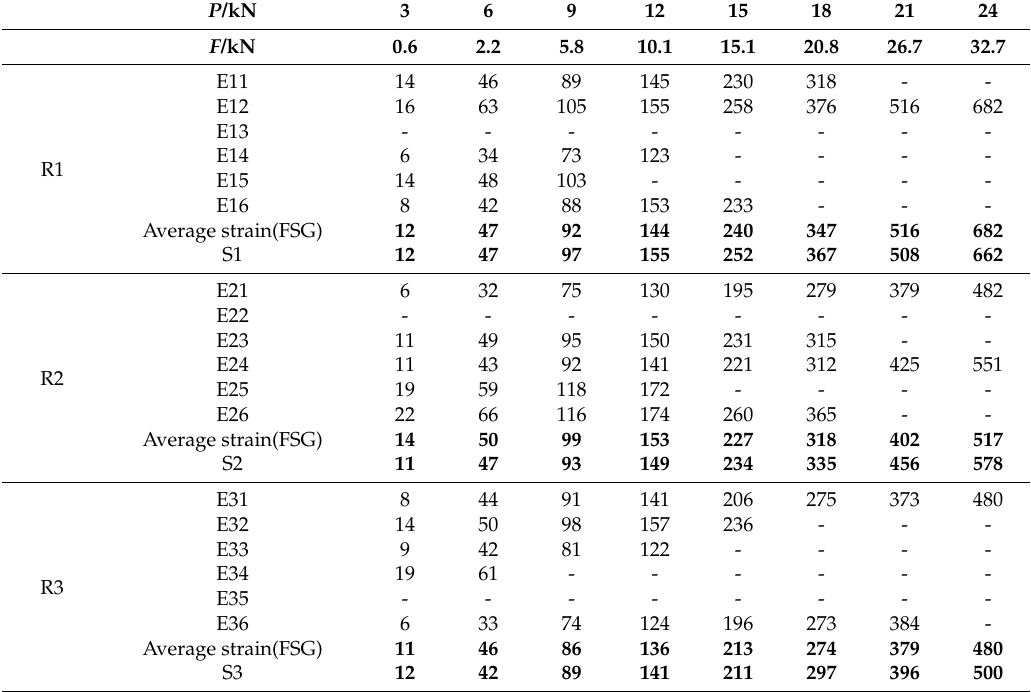
Table 5. The monitored strains of the strand at Step III. (Unit: µε ).